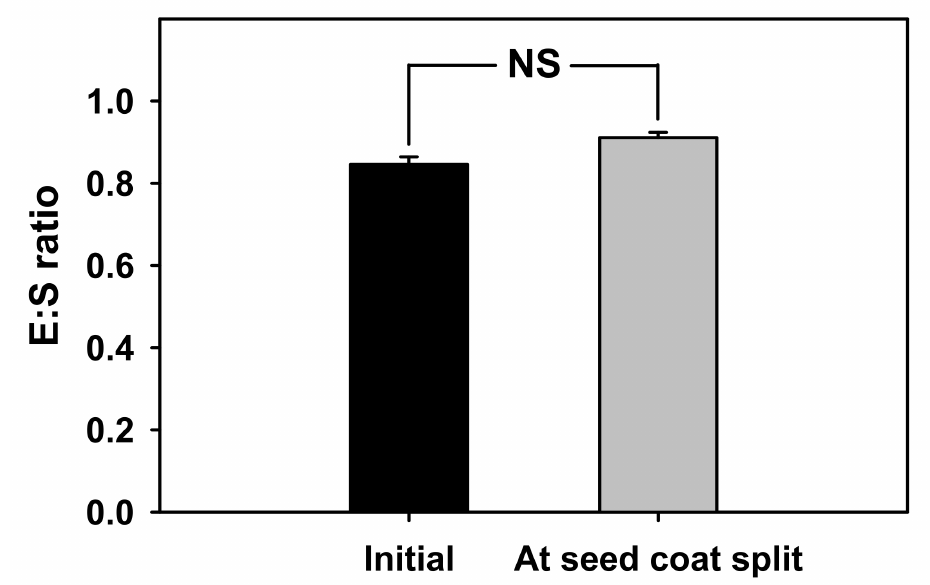
Figure 1. Embryo to seed length ratio (E:S ratio) at initial stage and seed coat split stage of V. sibir- icum . Error bars are mean ± standard error (SE) of ten replicates. The NS represents no-significant differences as determined by paired t